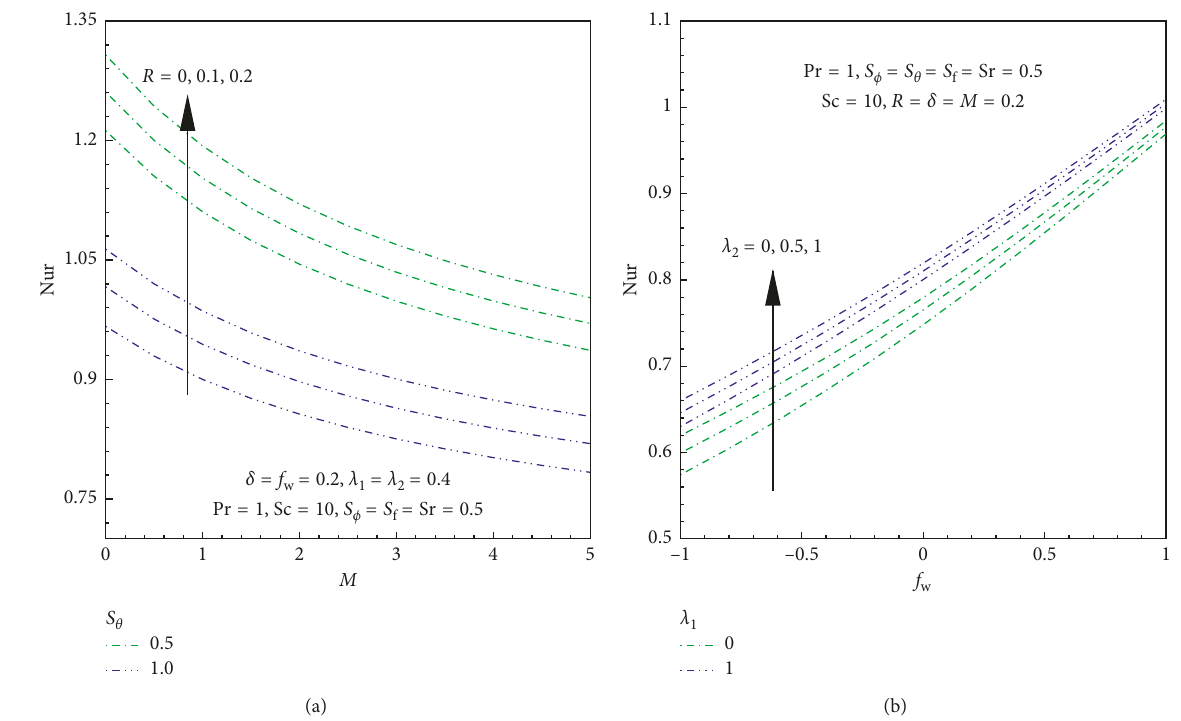
Figure 10: Effects of M,R, S